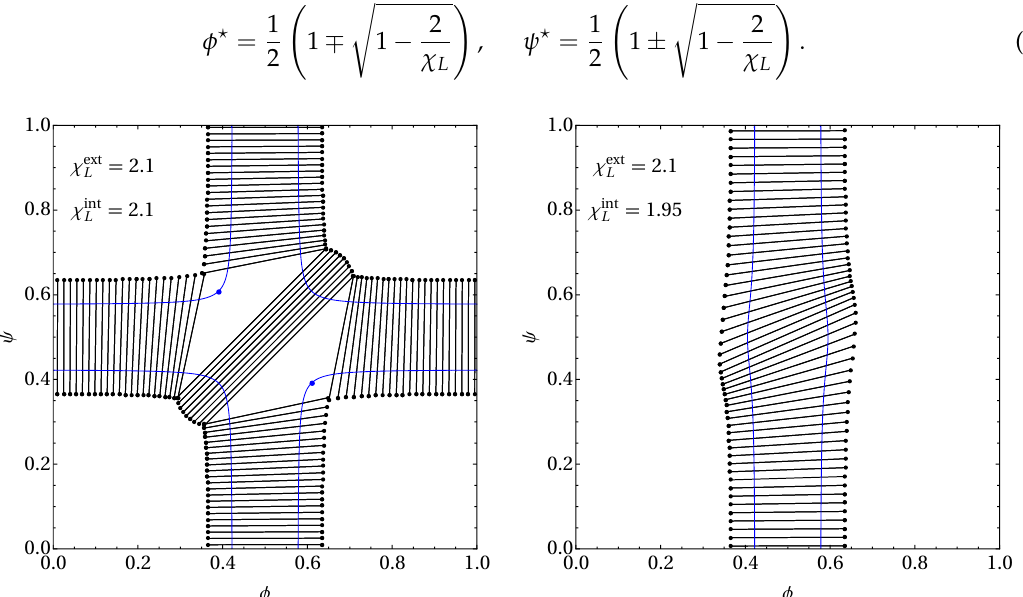
Figure 4. Phase diagrams in the absence of proteins, α = 0. The blue lines mark the spinodal. Tie lines (black solid lines) are terminated by black bullets. The left diagram is calculated for = χ int = 2.1 and the right diagram for χ ext χ ext L L is Λ = 0.05 in both diagrams. The left diagram exhibits two three-phase regions that each hide one critical point, marked by a blue